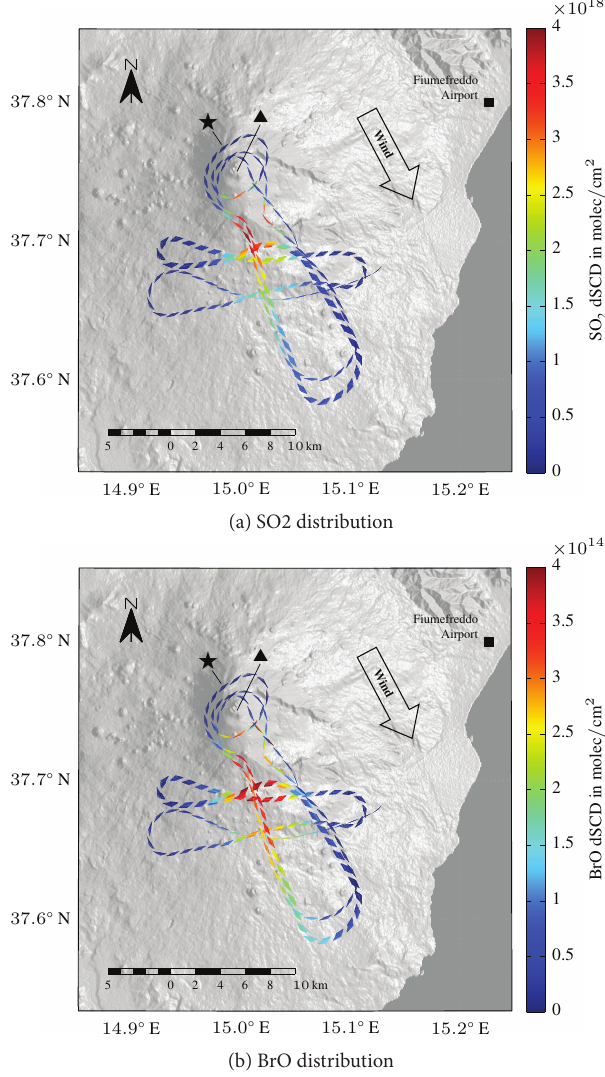
Figure 19. Maps showing the spatial distribution of SO 2 and BrO measured by HAIDI’s nadir scanner on 9 July 2011. Only data taken at altitudes greater than 3300m is displayed here. The wind direc- tion was taken from sounding balloon data (UWYO, 2011). H : Po- sition of in-flight reference spectrum, s : Location of Mt. Etna’s New Southeast